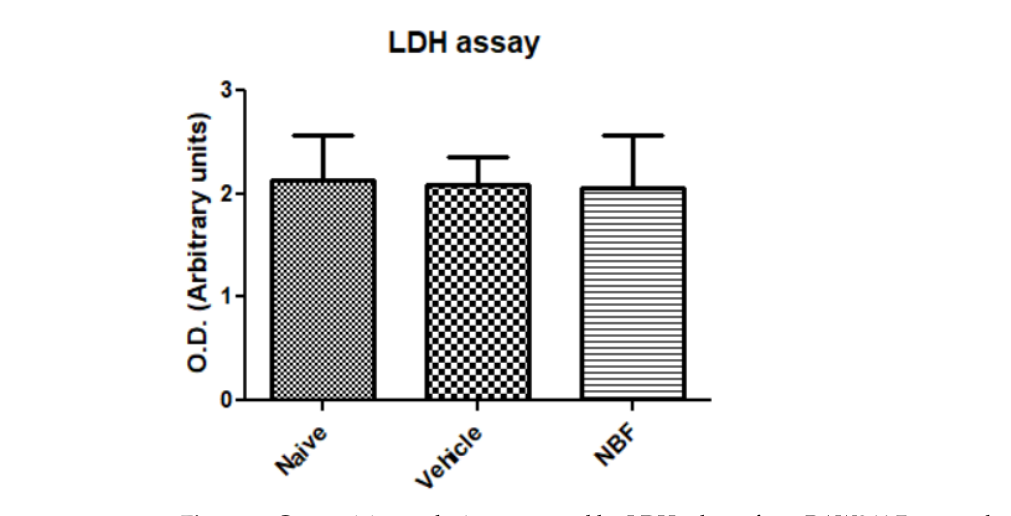
Figure 1. Cytotoxicity analysis as assessed by LDH release from RAW264.7 macrophages. LDH levels were measured by O.D. (arbitrary units) and are presented as the mean ± SD. At least 8 replicates were in each group ( n = 8 for naïve, n = 16 for vehicle, and n = 14 for NBF). ANOVA with Bonferroni’s post hoc test was performed. p -value = 0.92.